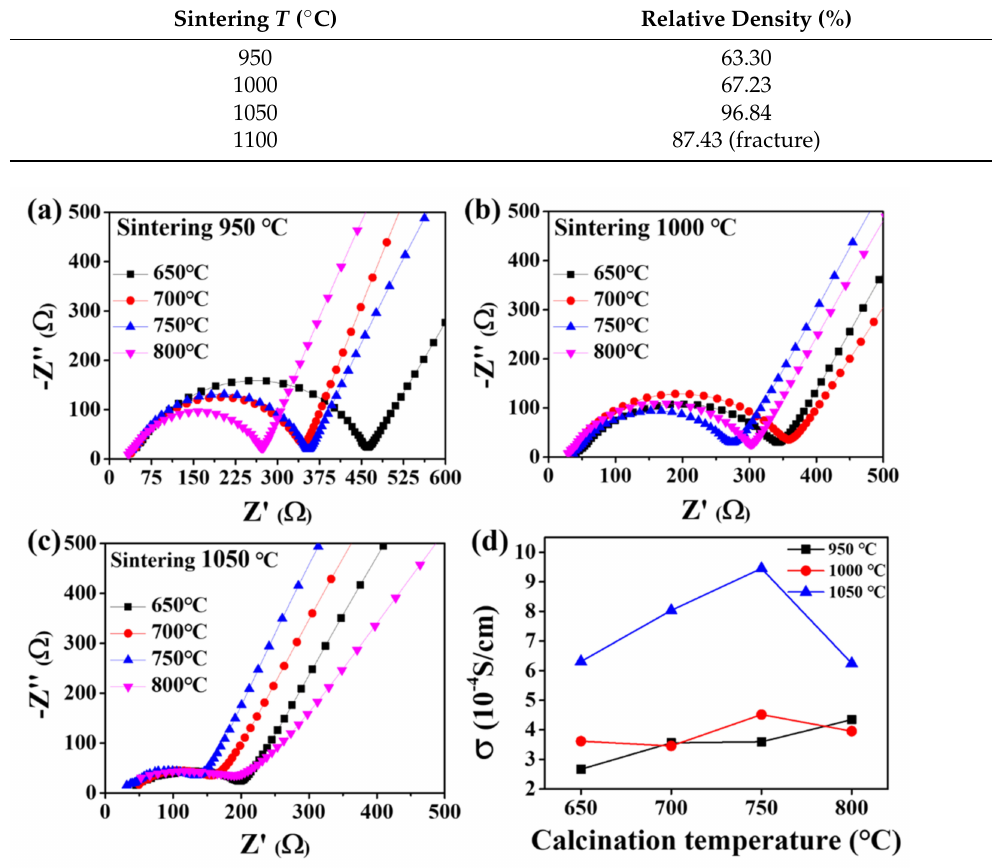
Table 1. Relative densities of the LASTP pellets sintered at various temperatures.